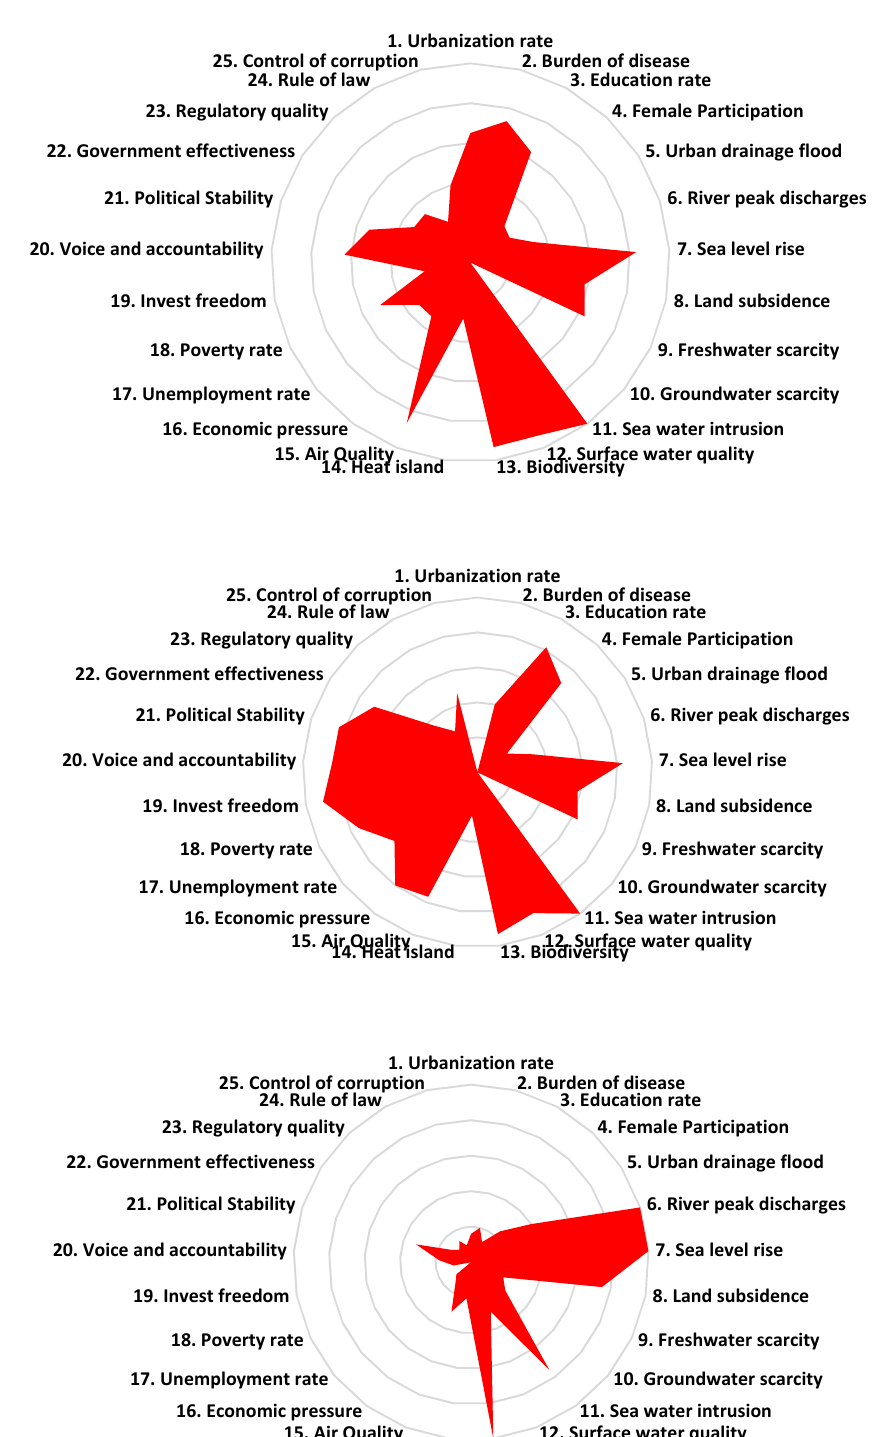
Figure 7. TPF of Amsterdam in 1672–1682 ( top ), 1780–1810 ( middle ), and 2018–present ( bottom ).